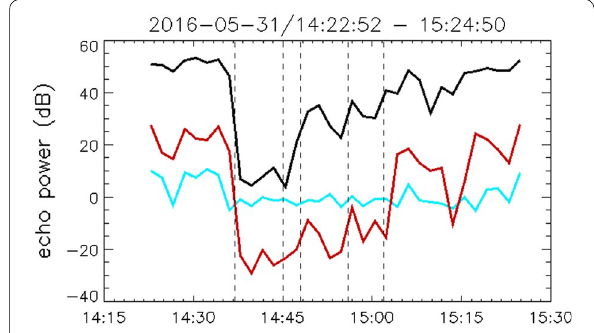
Fig. 9 Time variations of the RASS echo power at 1.64 km (black), 4.48 km (blue), and 7.92 km (red) from 14:22 to 15:24 LT on May 31, 2016. Operation of the speakers was changed at the timing of the vertical dashed lines (see text)